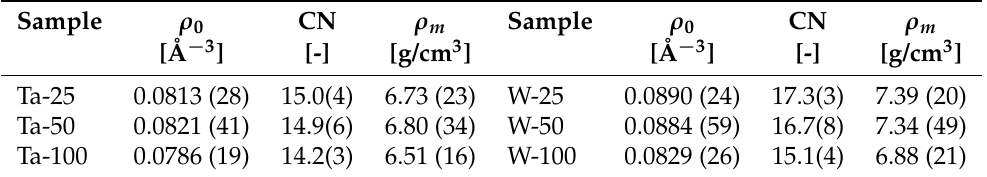
Table 2. Evolution of the mean atomic density ρ 0 and total coordination number CN for the Ta- and W-containing alloys during mechanical alloying. Mass density ρ m was calculated considering the nominal alloy composition and respective value of ρ 0